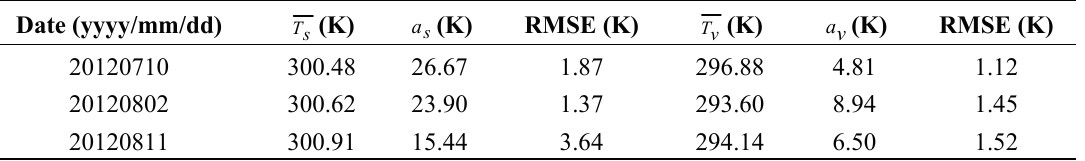
Figure 4. The T s (observed by tower AMS04) and T v (observed by tower AMS12) curves on ( a ) 10 July, ( b ) 2 August and ( c ) 11 August of 2012. Table 2. Regression parameters of the T s and T v curves and the root-mean-square errors (RMSEs).